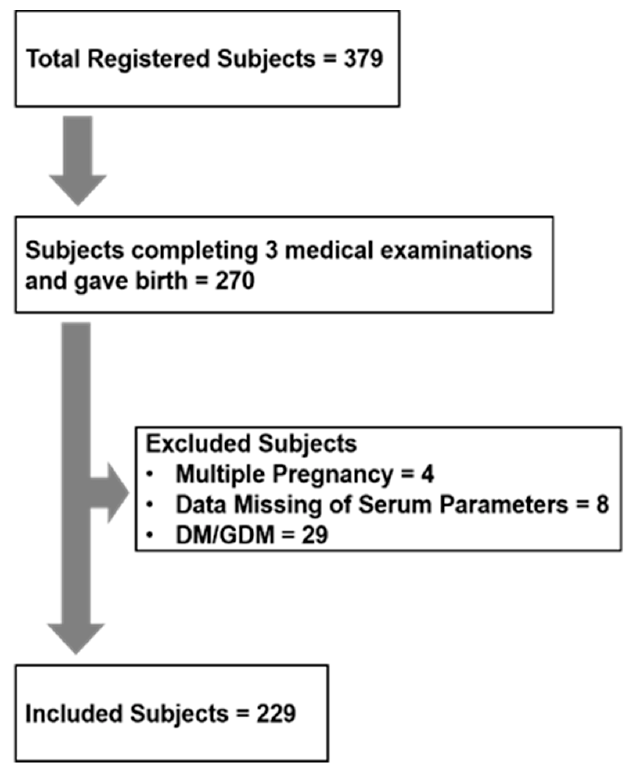
Figure 1. Flow chart for selecting subjects. A total of 379 subjects participated in this study, and 270 completed all three medical examinations during pregnancy, and gave birth. Four subjects were excluded as they had multiple pregnancies, 8 subjects were excluded as they had missing data on blood biochemistry, and 29 subjects were excluded as they were diagnosed with diabetes mellitus or gestational diabetes mellitus (DM/GDM). The remaining 229 participants were included in the analyses, and none of these participants were diagnosed with oxidative stress-related diseases such as liver diseases and renal failure.